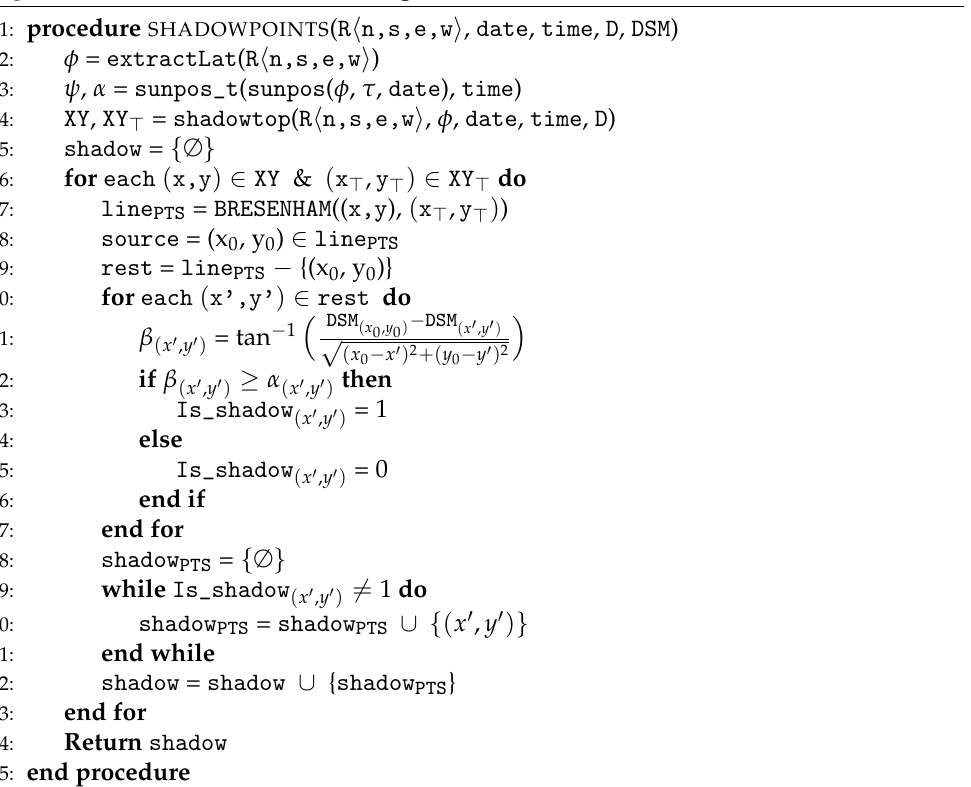
Algorithm 3 Calculate Shadow On Digital Surface